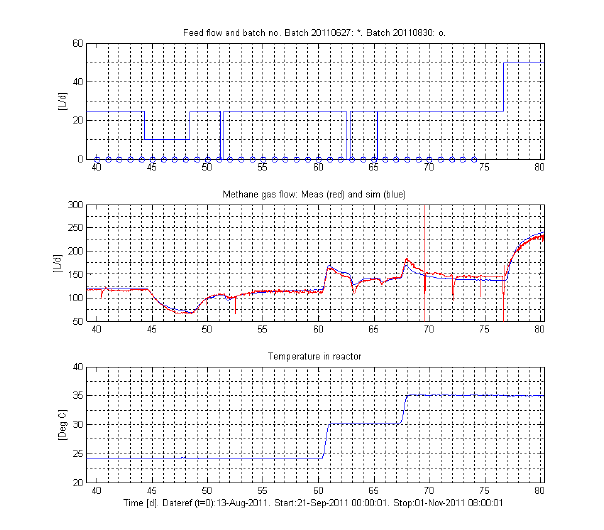
Figure 7: Reactor ADR1: Responses in F meth (middle) due to changes in T reac (lower) and F feed